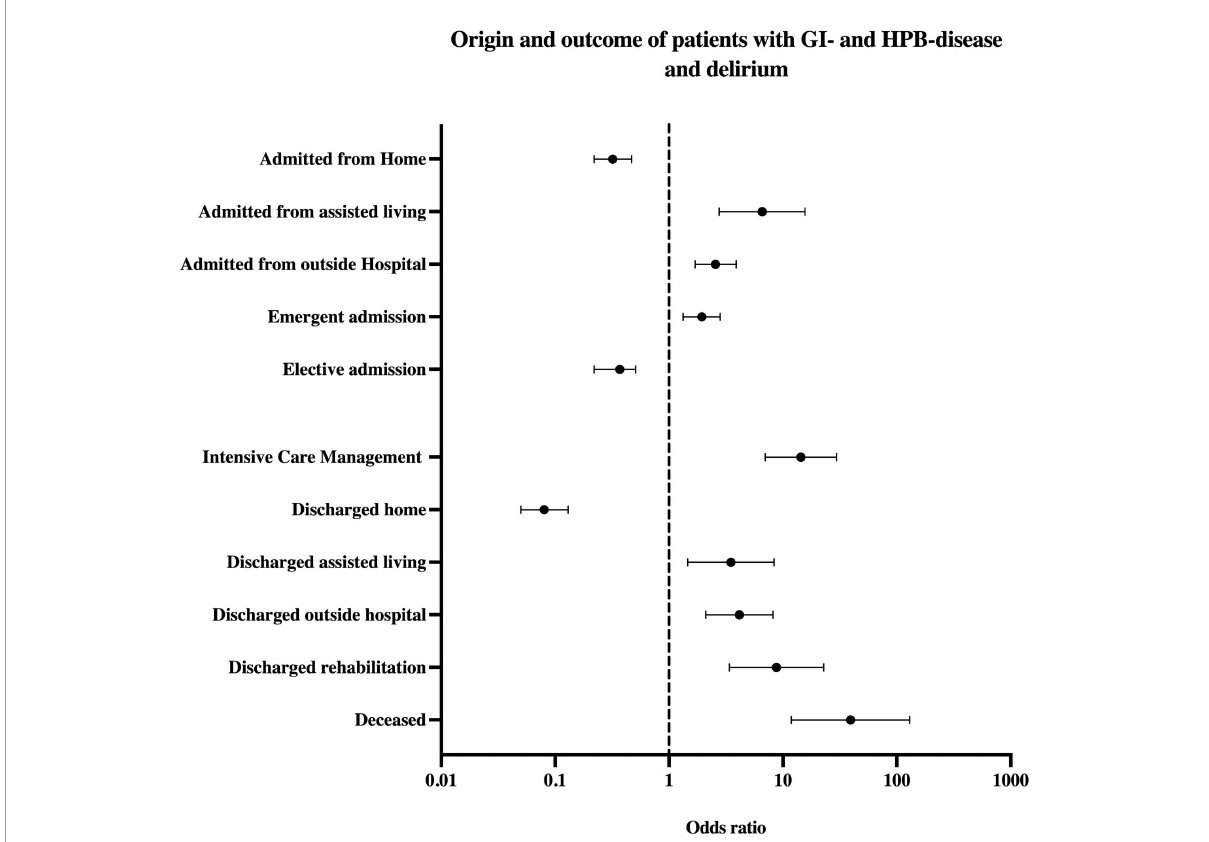
FIGURE2 Odds ratio by origin and outcome parameters of patients with delirium and GI-/HPB-disease. The upper part shows the origin before hospital admission and admission mode, below section transfer type and outcome. HPB,